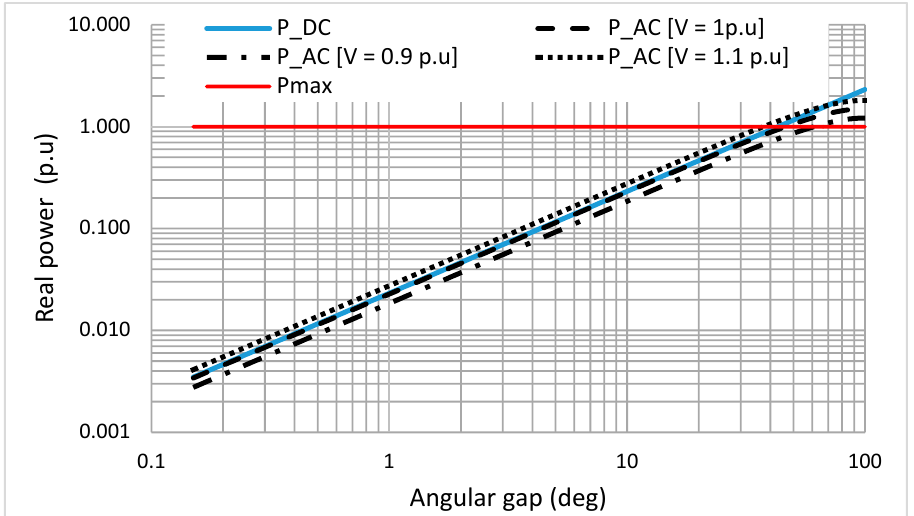
Figure 6. Comparison between the DC power flow and the AC power flow with sensitivity factors with three different voltage magnitudes.